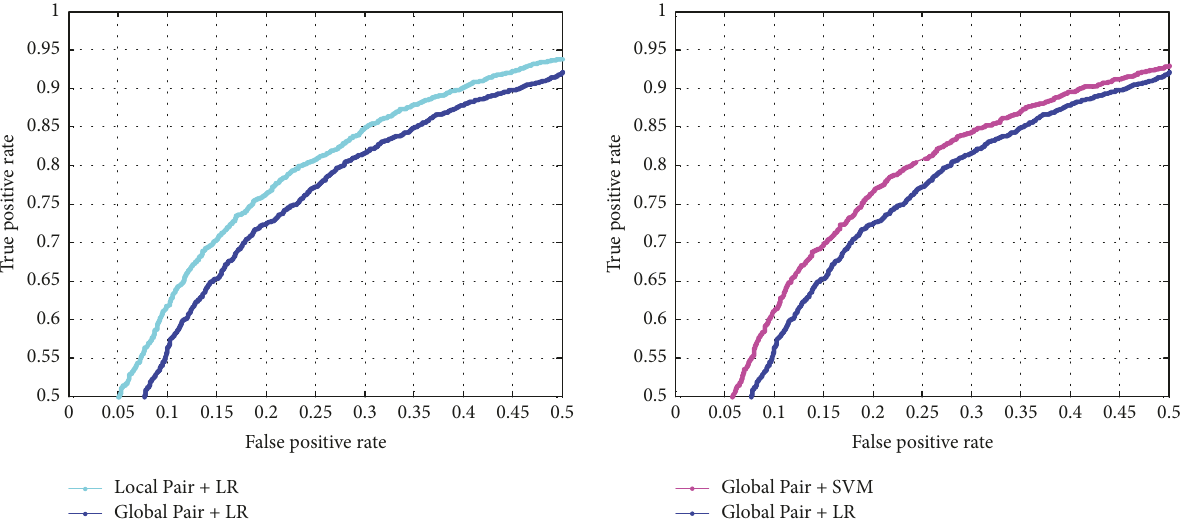
Figure 5: ROC curves of the system with different settings.